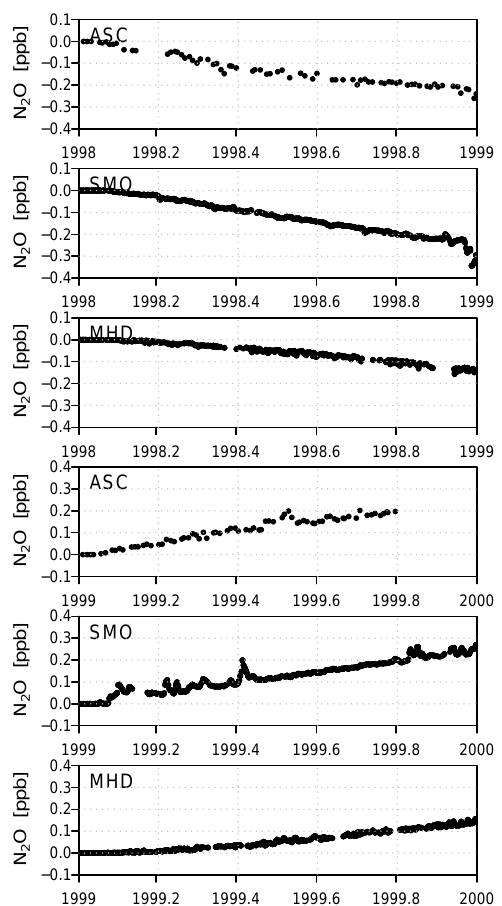
Fig. 3. Difference in mole fraction at Ascension Island (ASC, NOAA CCGG), America Samoa (SMO, AGAGE) and Mace Head (MHD, AGAGE) for the case of low vs. control fluxes in tropical South America and South America for an El Niño year (upper three panels) and for the case of high vs. control fluxes for a La Niña year (lower three panels). Model simulation has been sampled according to the available observations at these sites.